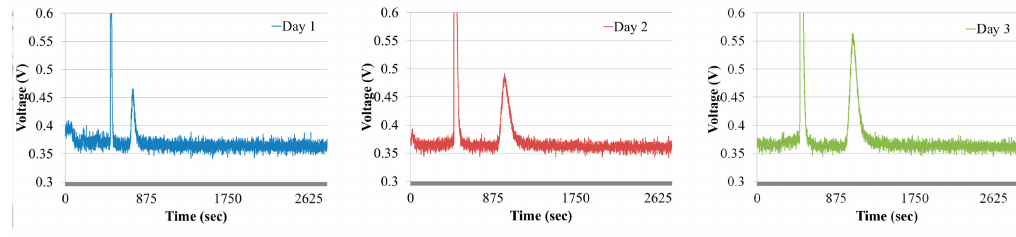
Figure 11. Ethylene chromatograms from ripening bananas.